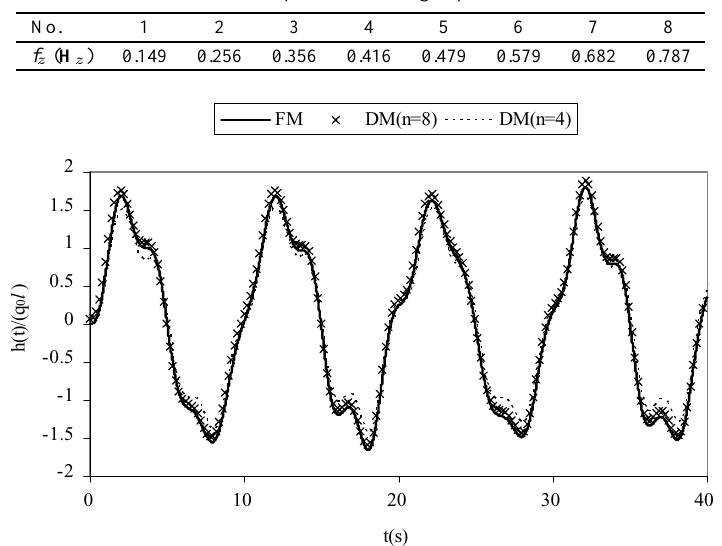
Table 1 Natural frequencies for a single span cable